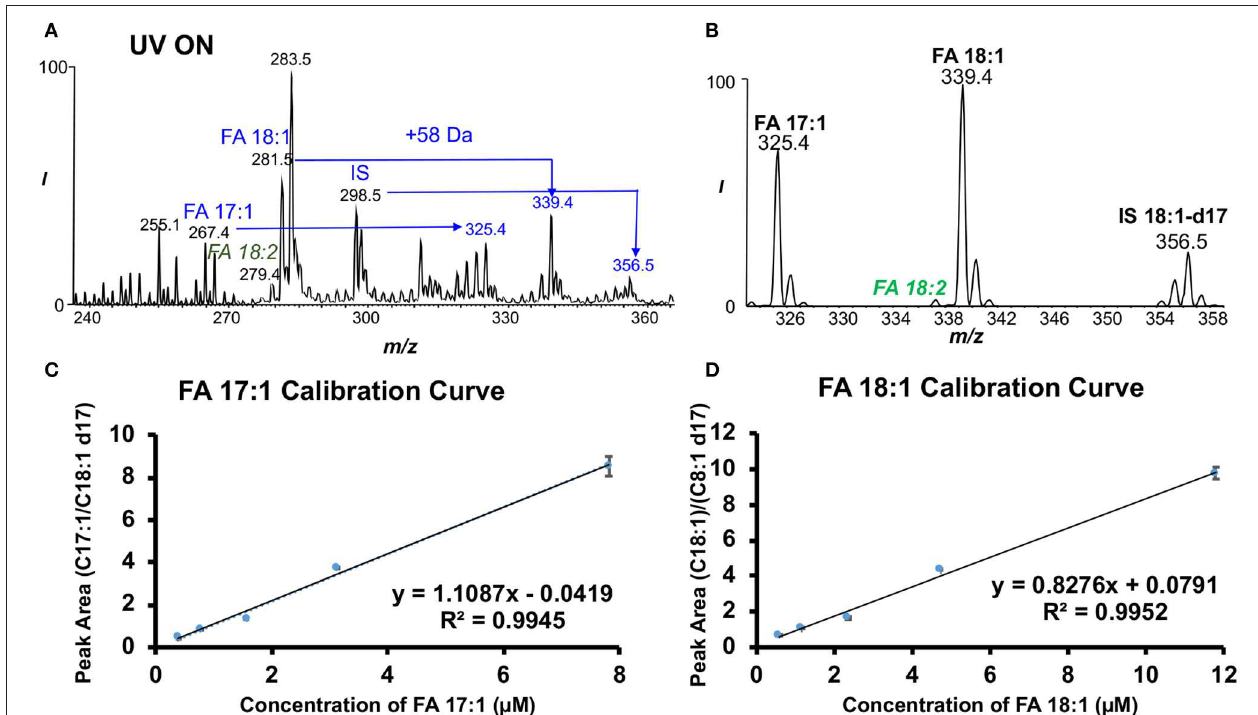
FIGURE 2 | Approach for the absolute quantitation of unsaturated fatty acids in the mouse spinal cords. (A) Negative ion mode nanoESI mass spectrum of FAs that were photochemically tagged by acetone. (B) Fifty-eight dalton neutral loss scan (NLS) after acetone tagging. Calibration curves for each data point with three replicates of (C) FA 17:1 and (D) FA 18:1 based on NLS with FA 18:1-d17 as